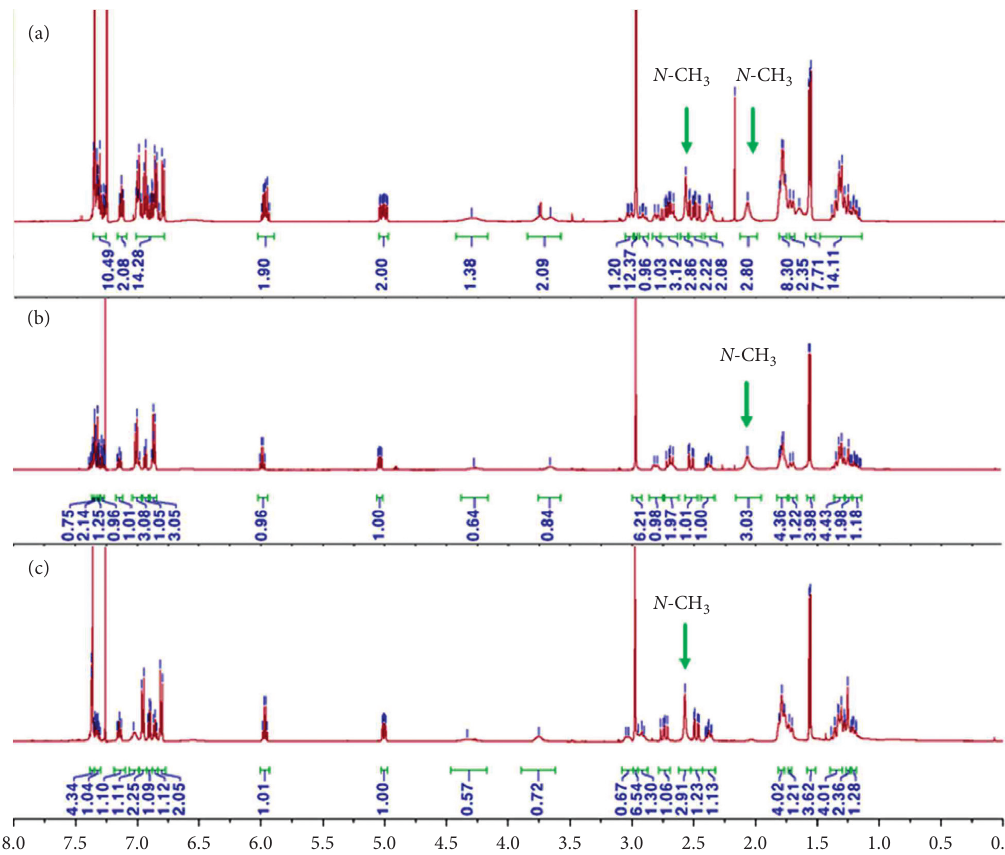
Figure 4: 1 H NMR spectra of (a) a mixture of diastereomeric esters 8a and 8b ; (b) ( S , 4 R )- 8a ; (c) ( S , 4 S )- 8b